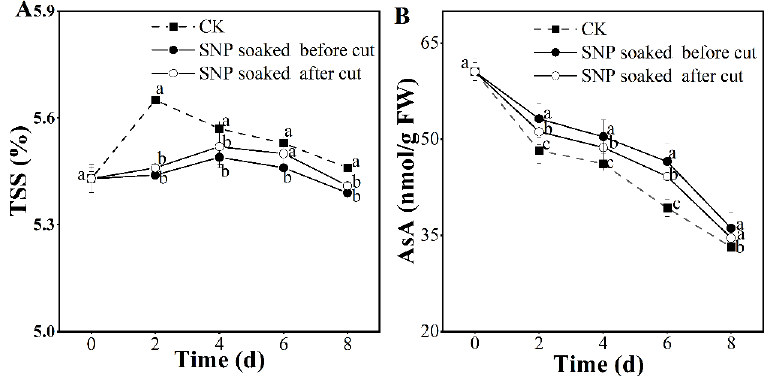
Figure 4. Effect of SNP treatment on nutritional properties of fresh-cut potatoes. TSSs ( A ) and AsA ( B ). Different letters indicate significant differences among treatments at same storage time ( p < 0.05).